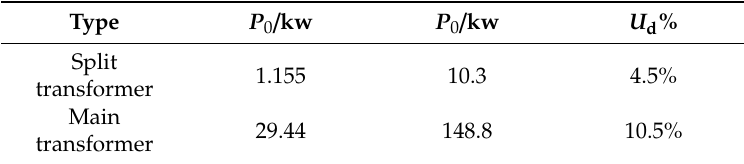
Table 3. Voltage amplitude intervals. Node Number